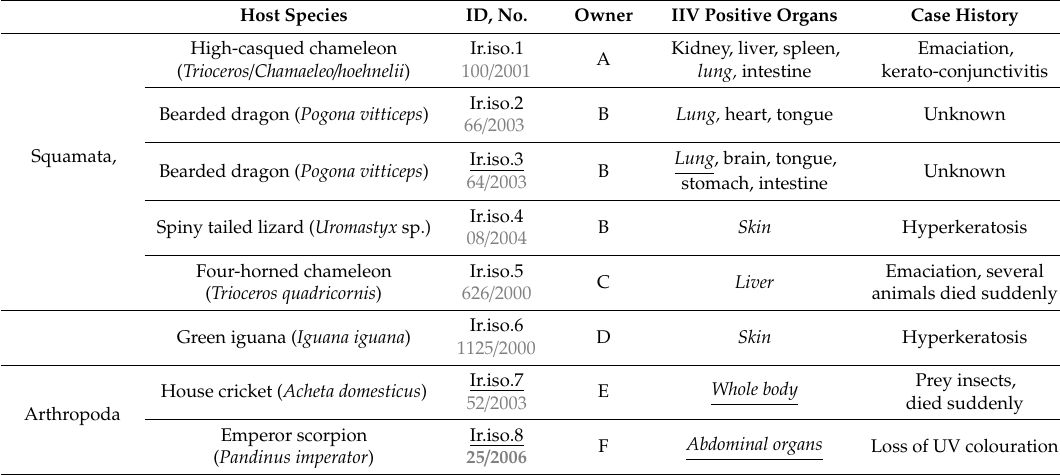
Table 1. Invertebrate iridovirus (IIV) isolates used in sequencing studies and bioassays. Grey colored ID refers to laboratory notebook number, the final number is the year of collection. Of all positive organs listed, the origin of the isolates used in the sequence comparison is printed in italics. Isolates compared in a cricket bioassay are